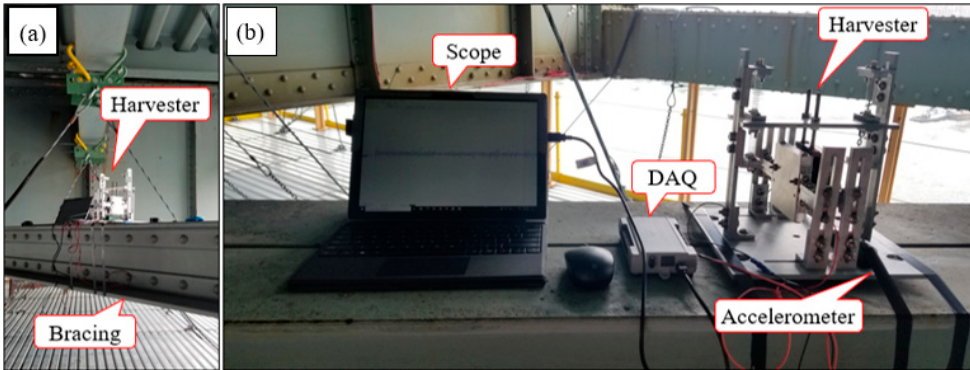
Figure 15. Field testing of the proof-of-concept prototype of EMEH ( a ) placement of the device on the middle of a horizontal lateral bracing of the deck, and ( b ) testing setup.